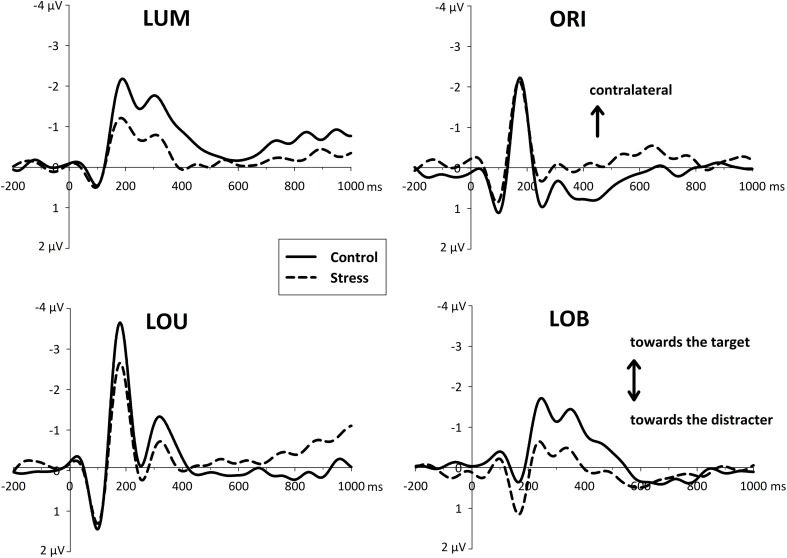
Event-related asymmetries (ERL's, difference waves between activity contralateral and ipsilateral to an event) of the EEG over posterior electrodes (PO7/PO8) separately for each type of change (LUM, ORI, LOU, LOB). The increase of negativity contralateral to a unilateral transient (LUM, ORI, LOU) is plotted upward. For ERLs of the central conflict condition (LOB) negativity contralateral to the target stimulus is plotted upward. In the time window of the N1 ERLs indicate the capture of attention toward the more salient element. Subsequent asymmetries in the N2 range (N2pc) were decreased for the stressed participants.